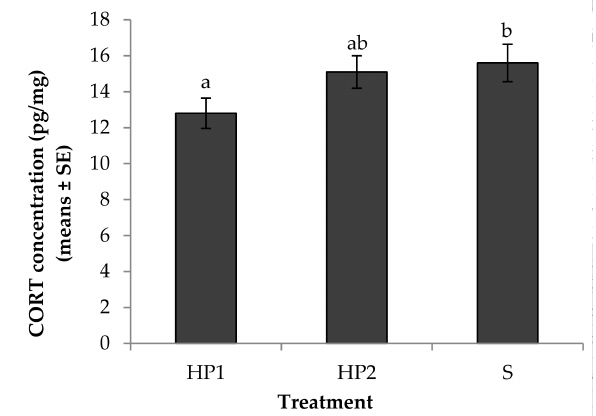
Figure 5. Means depicting the effect of human exposure of ostrich chicks for three months on their corticosterone (CORT) concentration from the floss feathers harvested at 7.5 months old as an indicator of chronic stress responses. ( N = 48). The birds in HP1 treatment ( N = 16) were exposed to extensive human presence with physical contact (touch, stroking), gentle human voice, and visual stimuli. The birds in HP2 treatment ( N = 16) were exposed to extensive human presence with gentle human voice and visual stimuli, but without physical contact. The birds in S treatment ( N = 16) had human presence limited to the provision of food and fresh water. Means with different superscripts differed significantly ( p < 0.05).